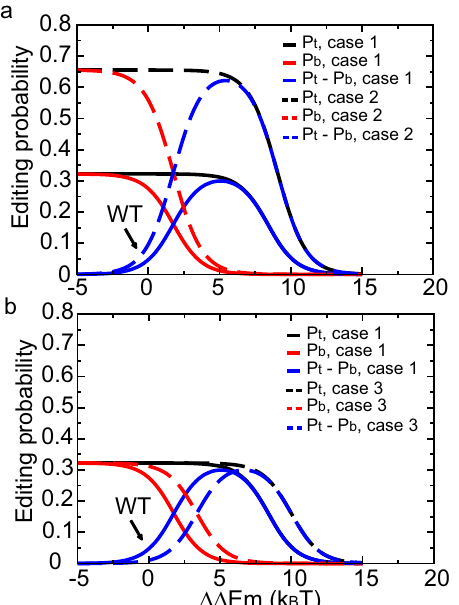
Fig. 5 Theoretical calculations on regulating the base editing pattern of and ( b ) γ . A3A-BE3. Base editing pattern of A3A-BE3 regulated by ( a ) γ 1 3 The de fi nition of 44 E m , γ and γ can be found in Eqs. (10,13 – 15). P t and P b 1 3 are the overall probabilities of editing the target and bystander cytidine, respectively. The difference between P t and P b is shown in blue. The setting with original parameters is represented by solid lines (case 1) whereas variants are represented by dashed lines (case 2: γ divided by fi ve; case 3: 1 γ divided by fi ve). Source data are provided as a Source Data fi 3